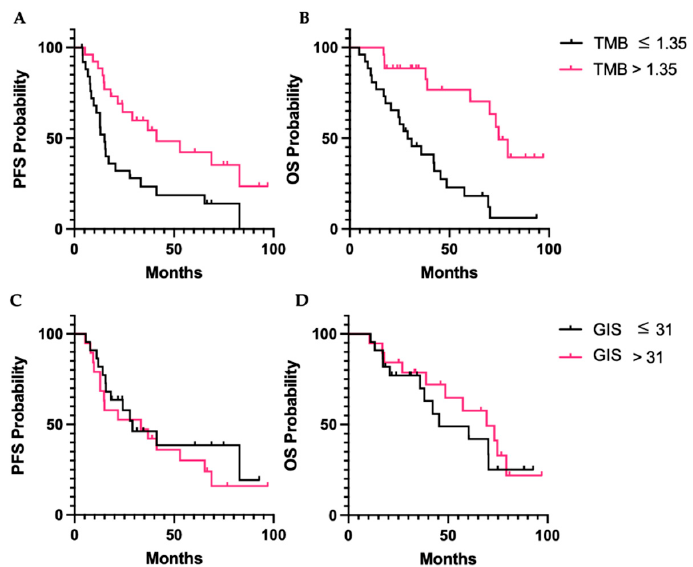
Figure 5. Survival outcomes for patients with uterine serous cancer by TMB and GIS. ( A , B ): PFS and OS with TMB above and below or equal to the median, 1.35. ( C , D ): PFS and OS for patients with GIS above and below or equal to the median. Abbreviations: GIS, genomic instability score; TMB, tumor mutation burden; PFS, progression-free survival; OS, overall survival.